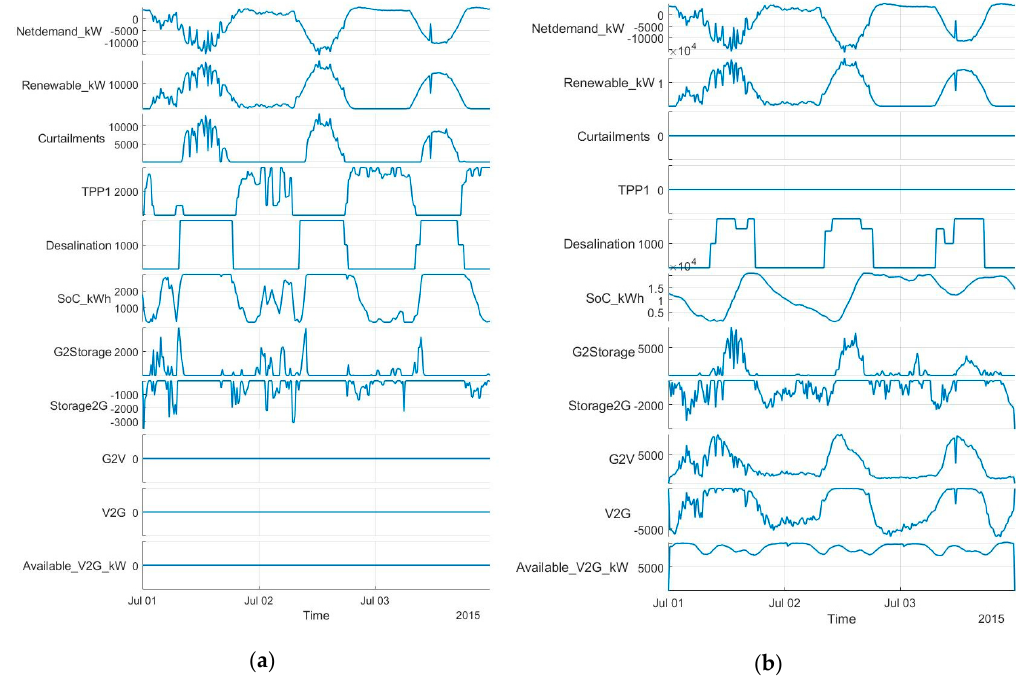
Figure 9. Overall system performance for the 1st, 2nd, and 3rd of July. ( a ) represents the results for the actual condition of the grid assets. ( b ) represents a scenario with 2500 EVs, BESS, and ICAES. As is illustrated in Figure 9b, the proposed optimized management of all resources let the TPP stay entirely off during the three days, and curtailments did not occur. RES could meet the total energy demand, whereas in Figure 9a, around 43% of the RES had to be rejected, and the TPP covered 30% of the island’s total demand. Figure 10 illustrates the results for scenario 5 in detail.